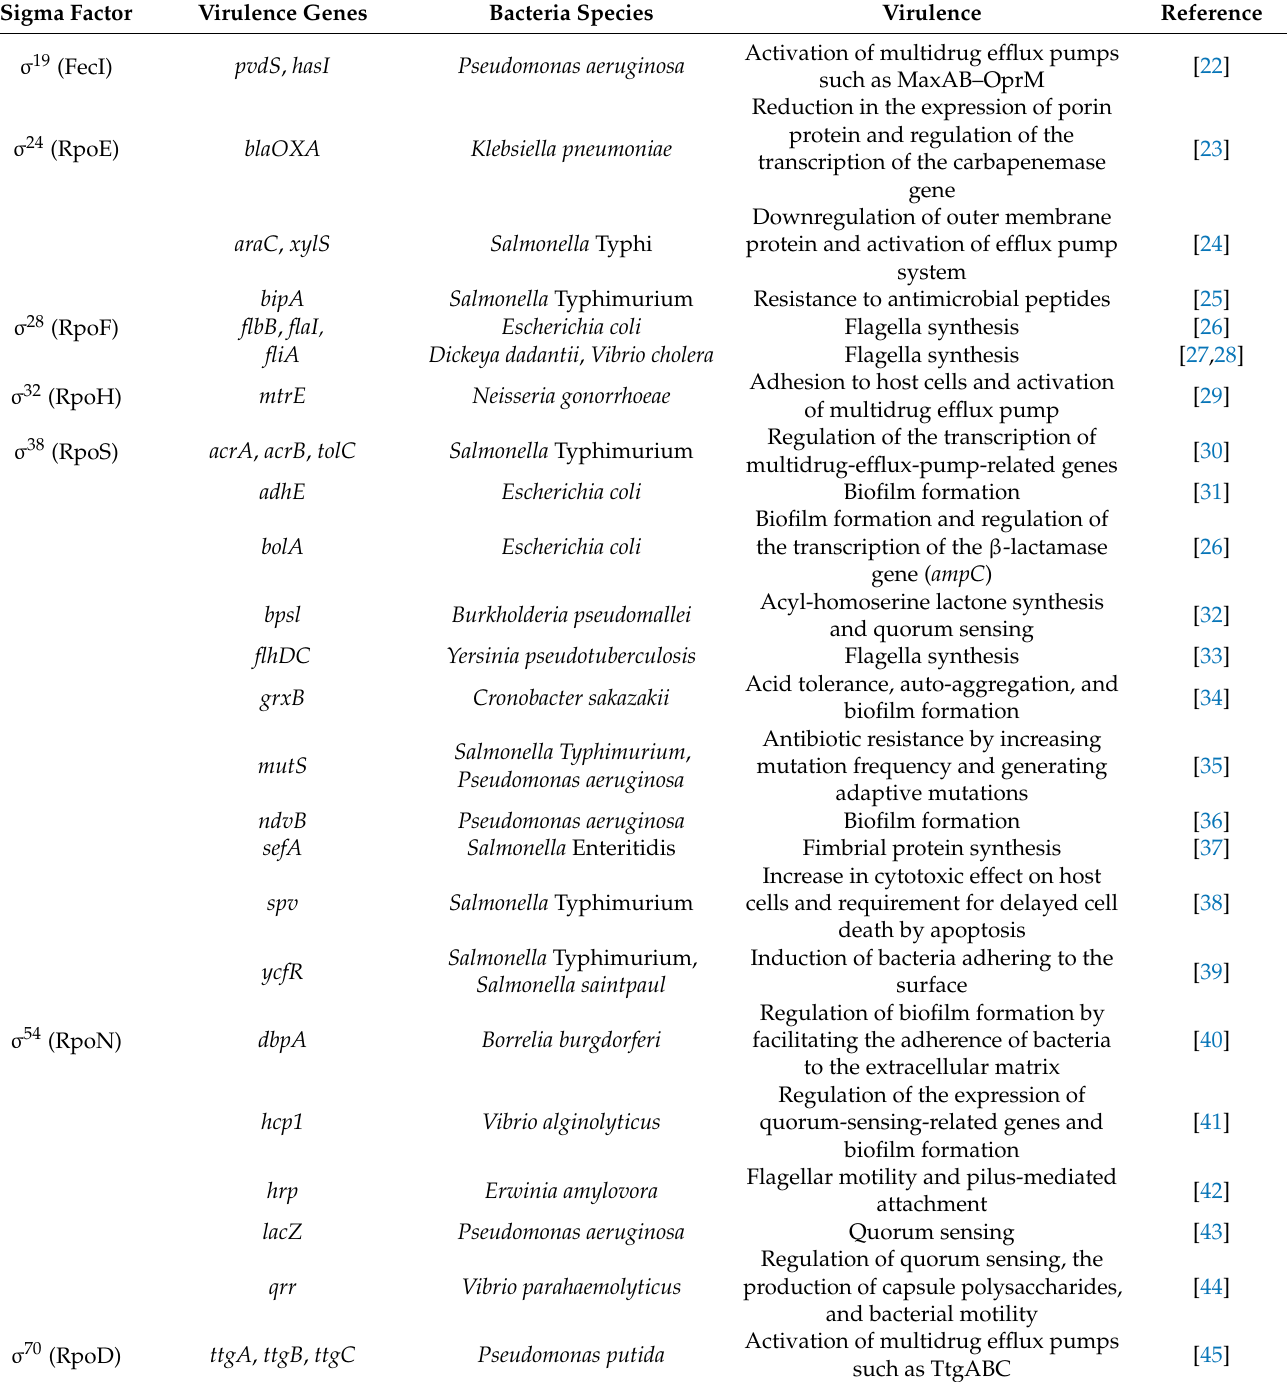
Table 1. Virulence genes involved in stress-related sigma-factor-induced antimicrobial resistance in Gram-negative